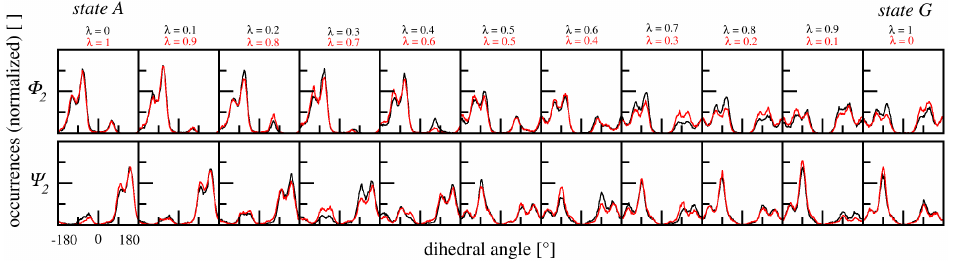
Figure 5. Dihedral angle distribution for KAK → KGK along forward (black) and backward (red) transformations in solvent. ϕ 2 / ψ 2 angles are monitored over a 10 ns simulation trajectory at each λ -point. Forward and backward transformations are in agreement for both angles. Additionally, distributions show clear peaks for the side chain bearing state A, and wider fluctuations for state G which lacks a side chain.